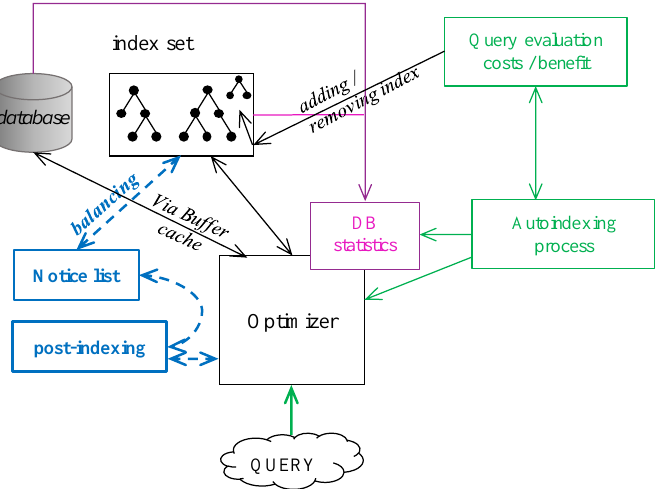
Figure 11. Autoindexing + post-indexing module.